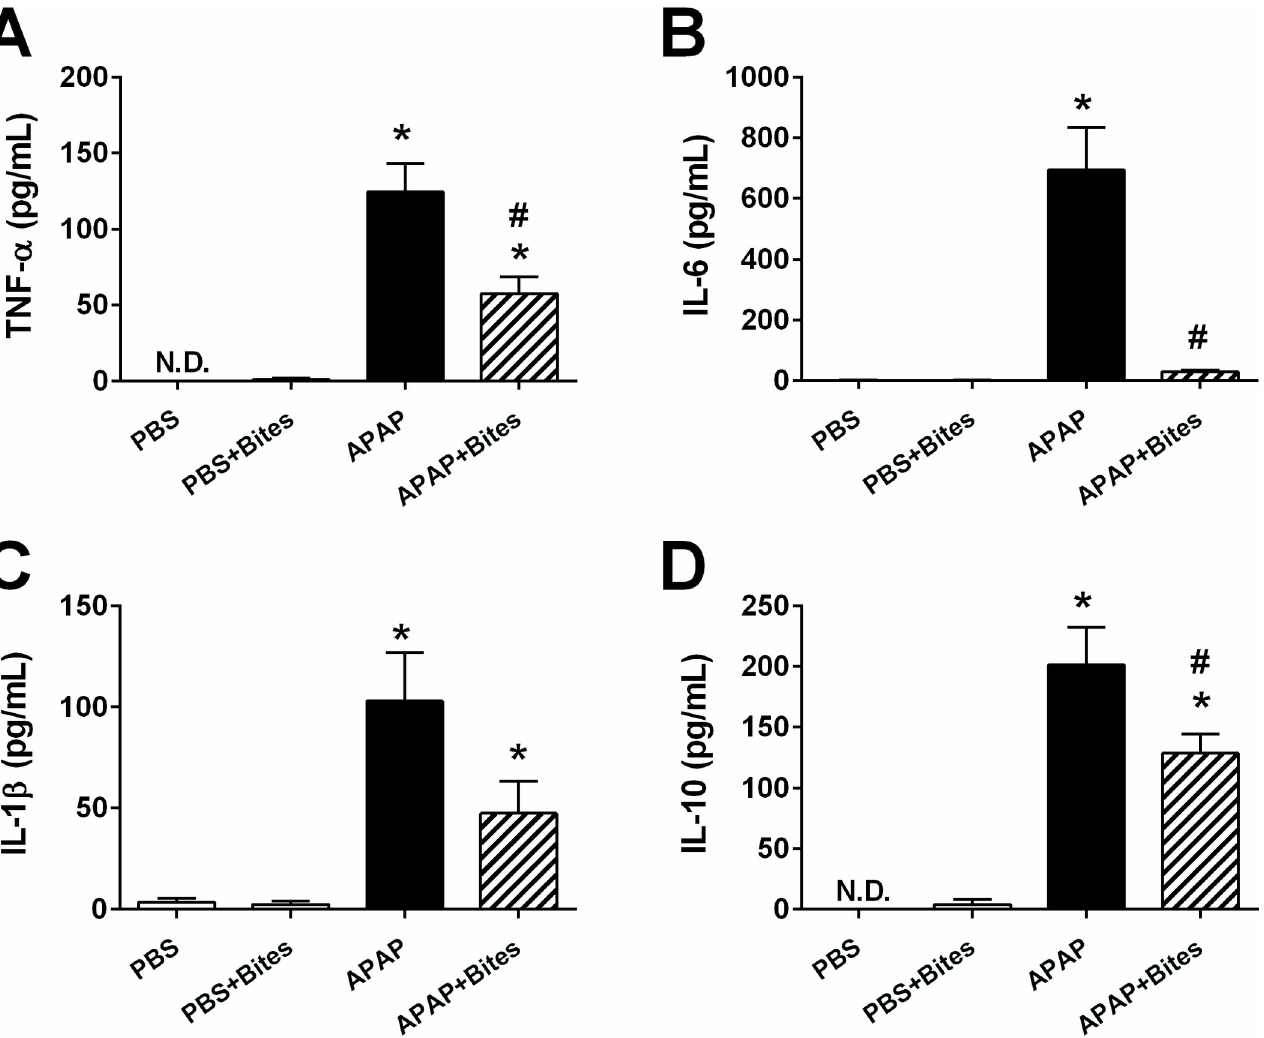
Fig 4. Cytokine production in the serum of mice injected with APAP and exposed to Ae . aegypti bites. C57BL/6 male mice were injected with PBS or APAP (300 mg/kg i.p.) and, after 2 hours, exposed to 30 Ae . aegypti mosquitoes. Blood was collected 24 hours after inoculation with PBS or APAP and cytokines were evaluated in the serum by ELISA. A. TNF- α ; B. IL-6; C. IL-1 β ; and D. IL-10. The data represent the mean ± SEM ( n = 5–10). � p < 0.05 versus “PBS” group; # p < 0.05 versus “APAP” group. N.D.: not